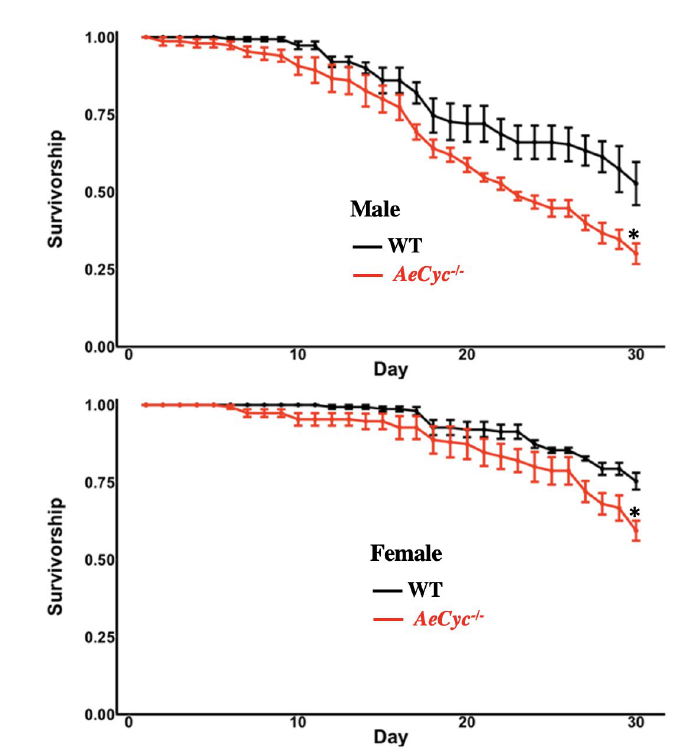
Figure 5. Survivorship of AeCyc −/− and wildtype Ae. aegypti males and females. *Statistically significant p ≤